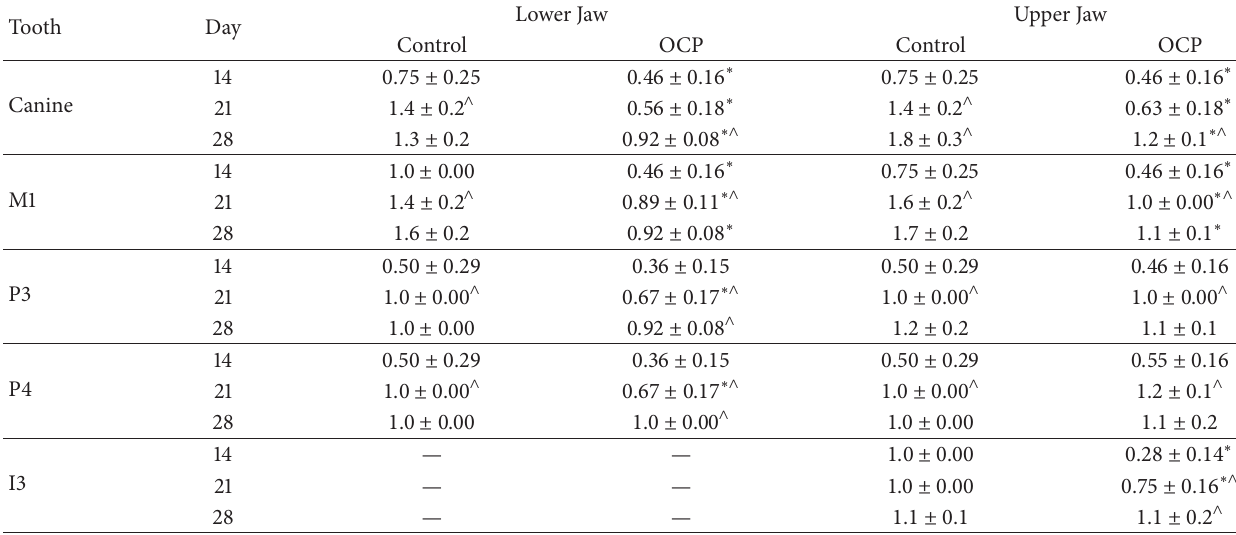
Table4:Plaquethicknessscoresonselectedteethinthelower(mandible)andupper(maxilla)jawsofcontrolandtreatmentdogs.Mandibular I3 was not part of the